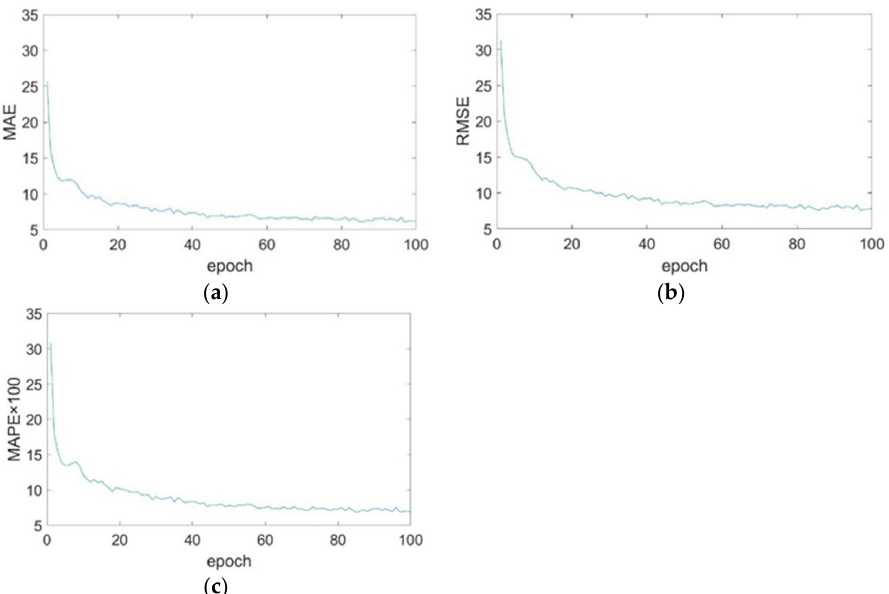
Figure 9. Mean absolute error (MAE), root mean square error (RMSE) and mean absolute percentage